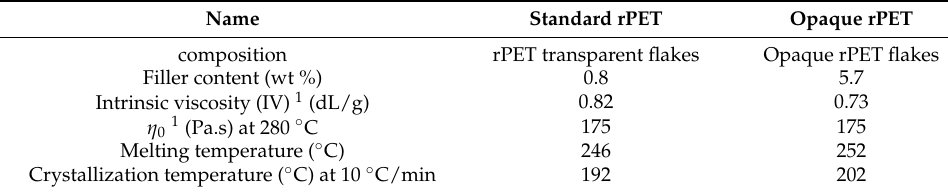
Table 1. Properties of the raw materials: Standard rPET and opaque